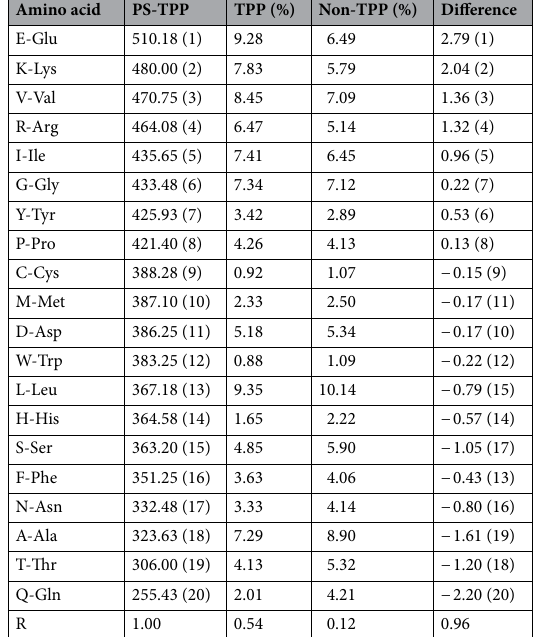
Table 7. Propensity scores of twenty amino acids in becoming a thermophilic protein (PS-TPP) along with amino acid compositions (%) of TPPs and non-TPPs.